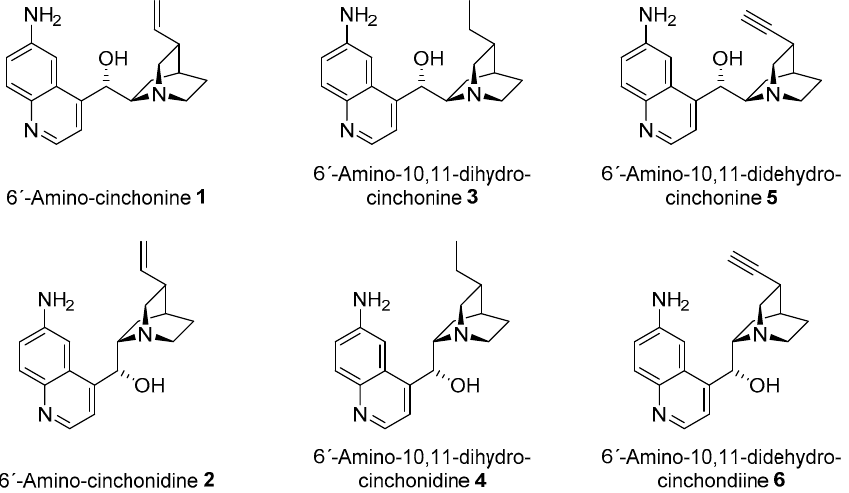
Figure 2. Starting materials: 6 ′ -Amino-cinchonine 1 and 6 ′ -Amino-cinchonidine 2, plus their hydrogenated derivatives ( 3 and 4 ) and their dehydrogenated derivatives ( 5 and 6 ).